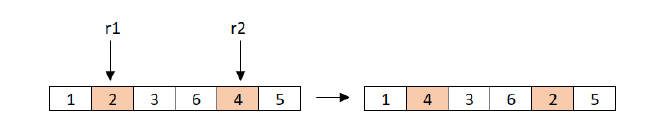
Fig. 4. Mutation representation. Made by the